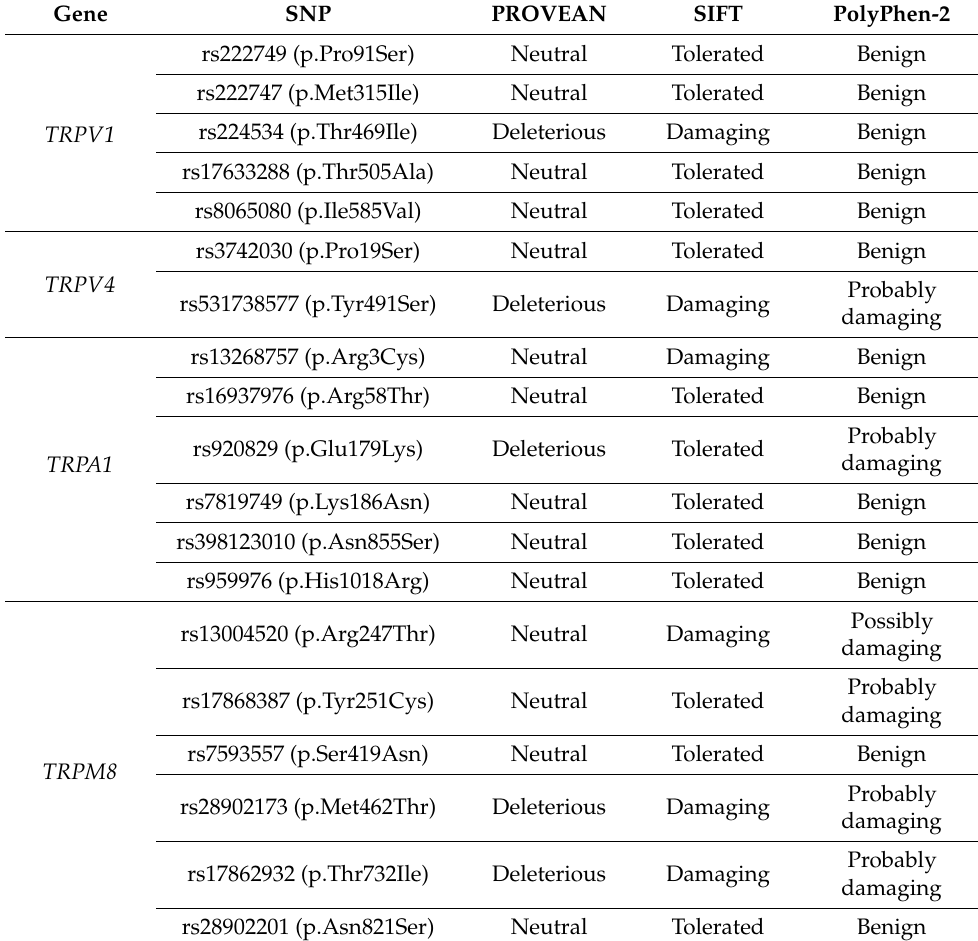
Table 4. Predicted effects of missense variations of TRPV1 , TRPV4 , TRPA1 , and TRPM8 genes. Gene